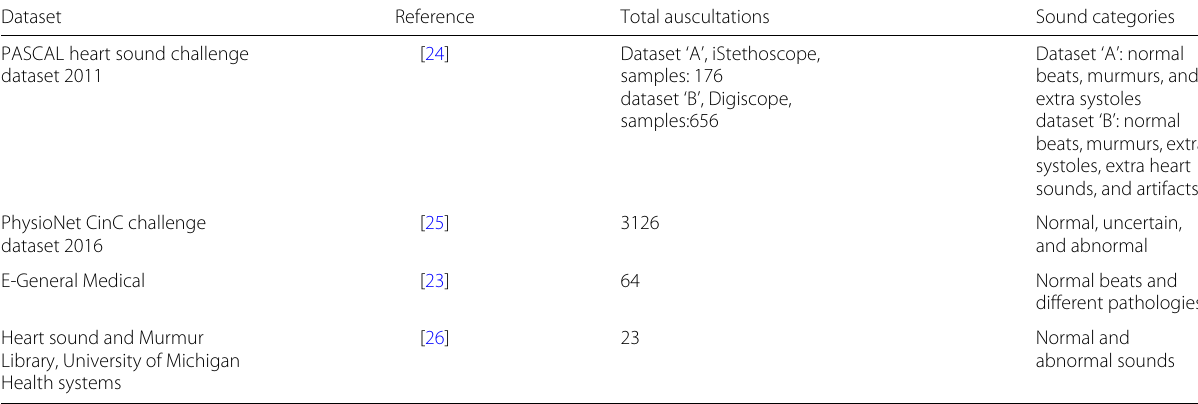
Table 1 A summary of PCG datasets